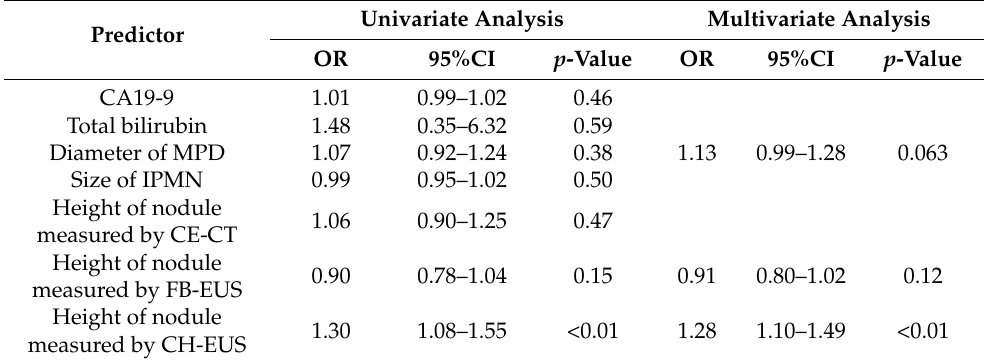
Table 3. The multivariate analysis for the examination of predictors of malignant